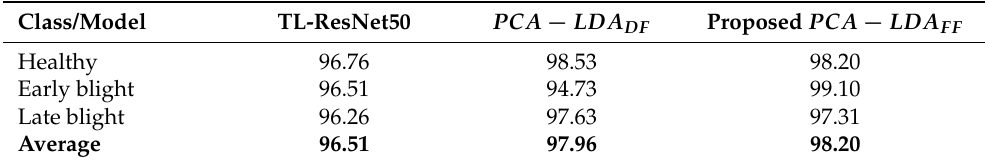
Table 2. Performance classification accuracy (%) of TL-ResNet50, PCA − LDA DF and PCA − LDA FF models using Transfer learning, deep features and fused features,